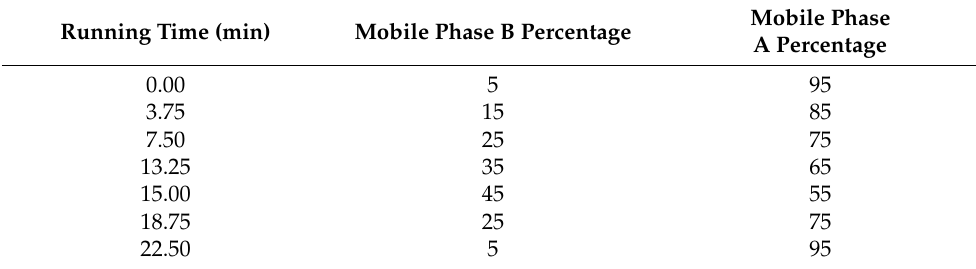
Table 4. Gradient elution mobile phase